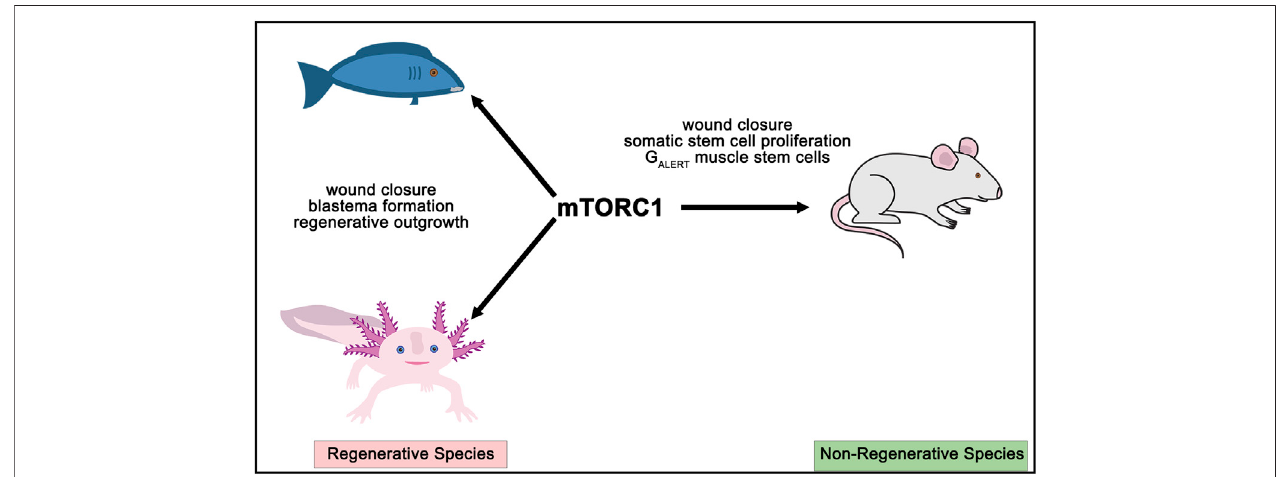
FIGURE 10 | Central position of mTORC1 as a critical regulator of tissue repair. mTORC1 drives wound closure, blastema formation and regenerative outgrowth, including in the retina, in teleost fi sh and the axolotl, both considered regenerative species. In non-regenerative species, such as mammal, mTORC1 signaling is also important for wound closure, somatic stem cell proliferation, and for the initial activation of dormant stem cells in skeletal muscle to a G ALERT phase.